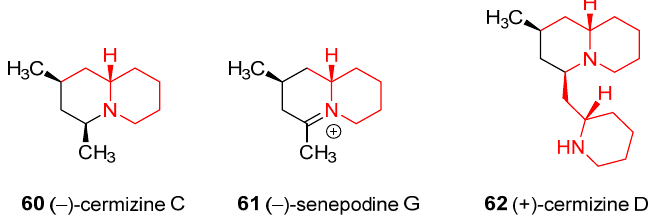
Figure 5. Structures of the alkaloids ( − )-cermizine C, ( − )-senepodine G, and (+)-cermizine D.